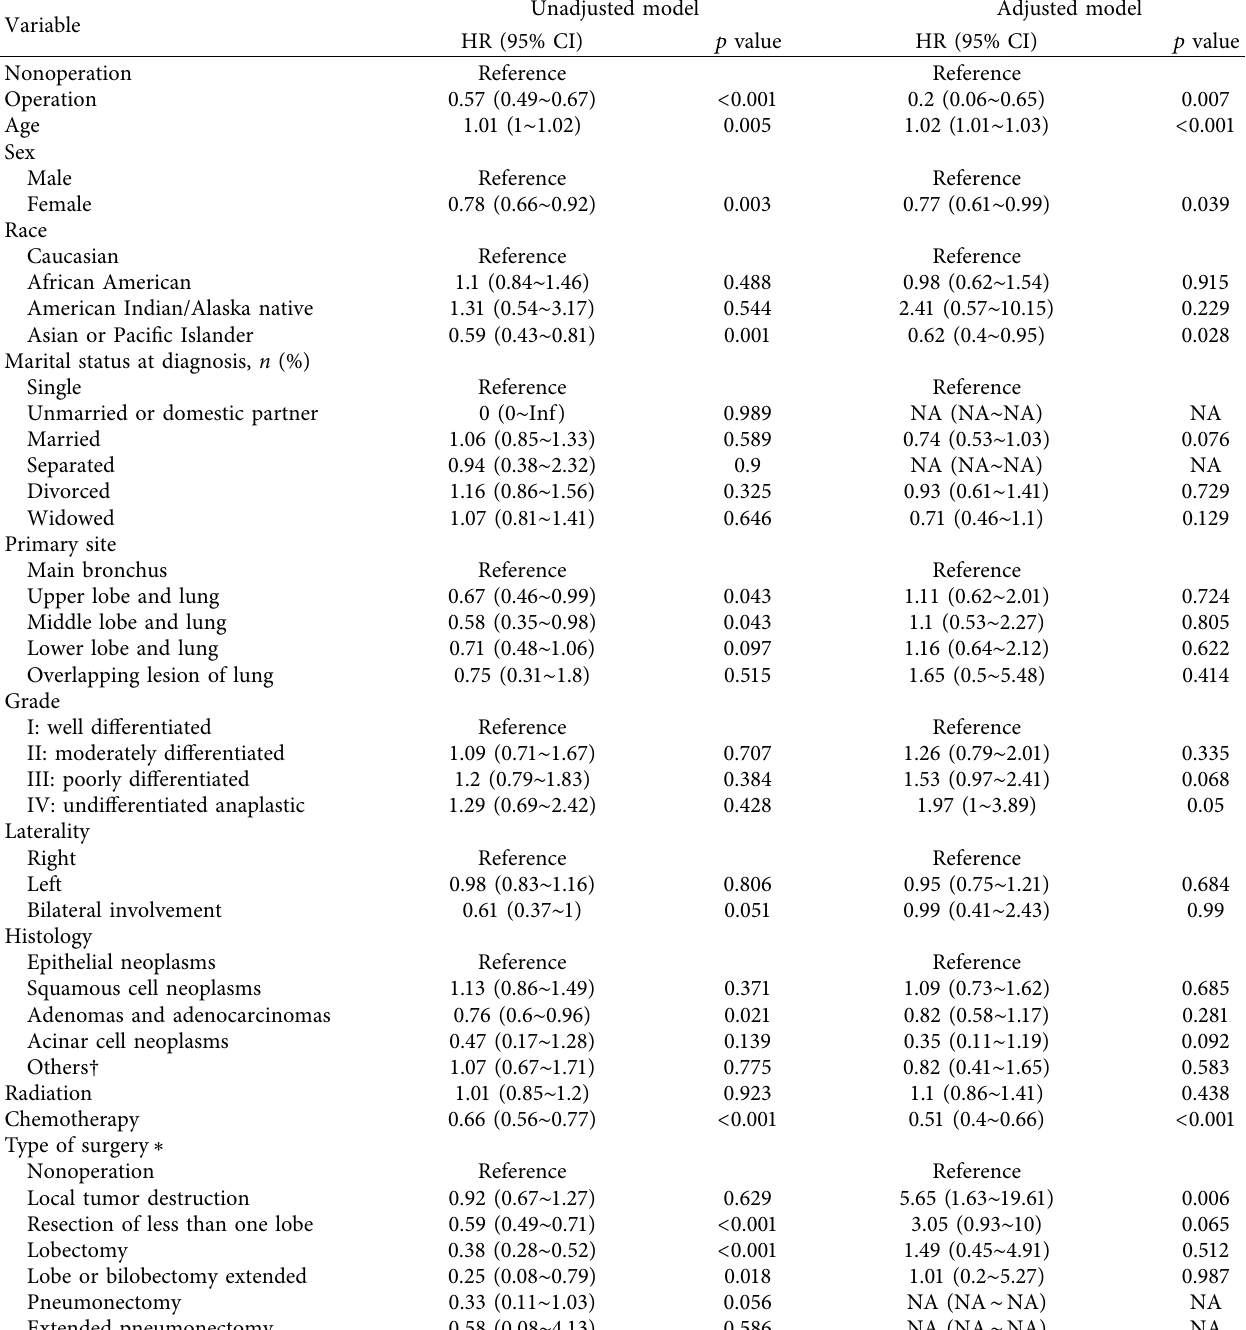
Table 4: Te multivariable Cox proportional hazard regression analyses for stage